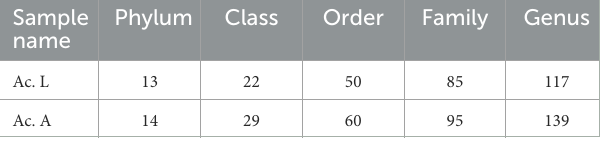
TABLE 3 Bacterial community composition within A. camelliae